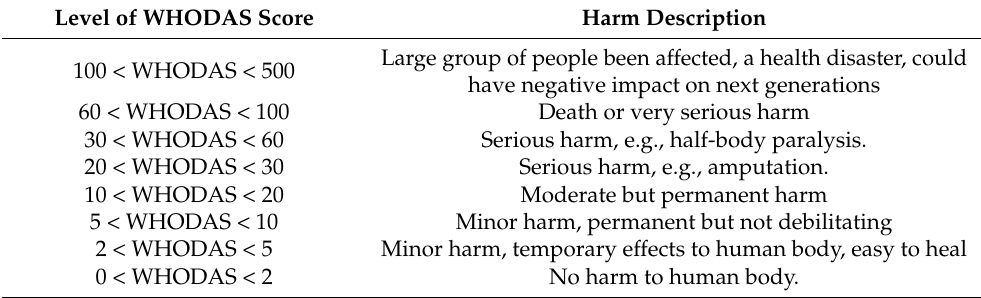
Table 2. WHODAS categories.